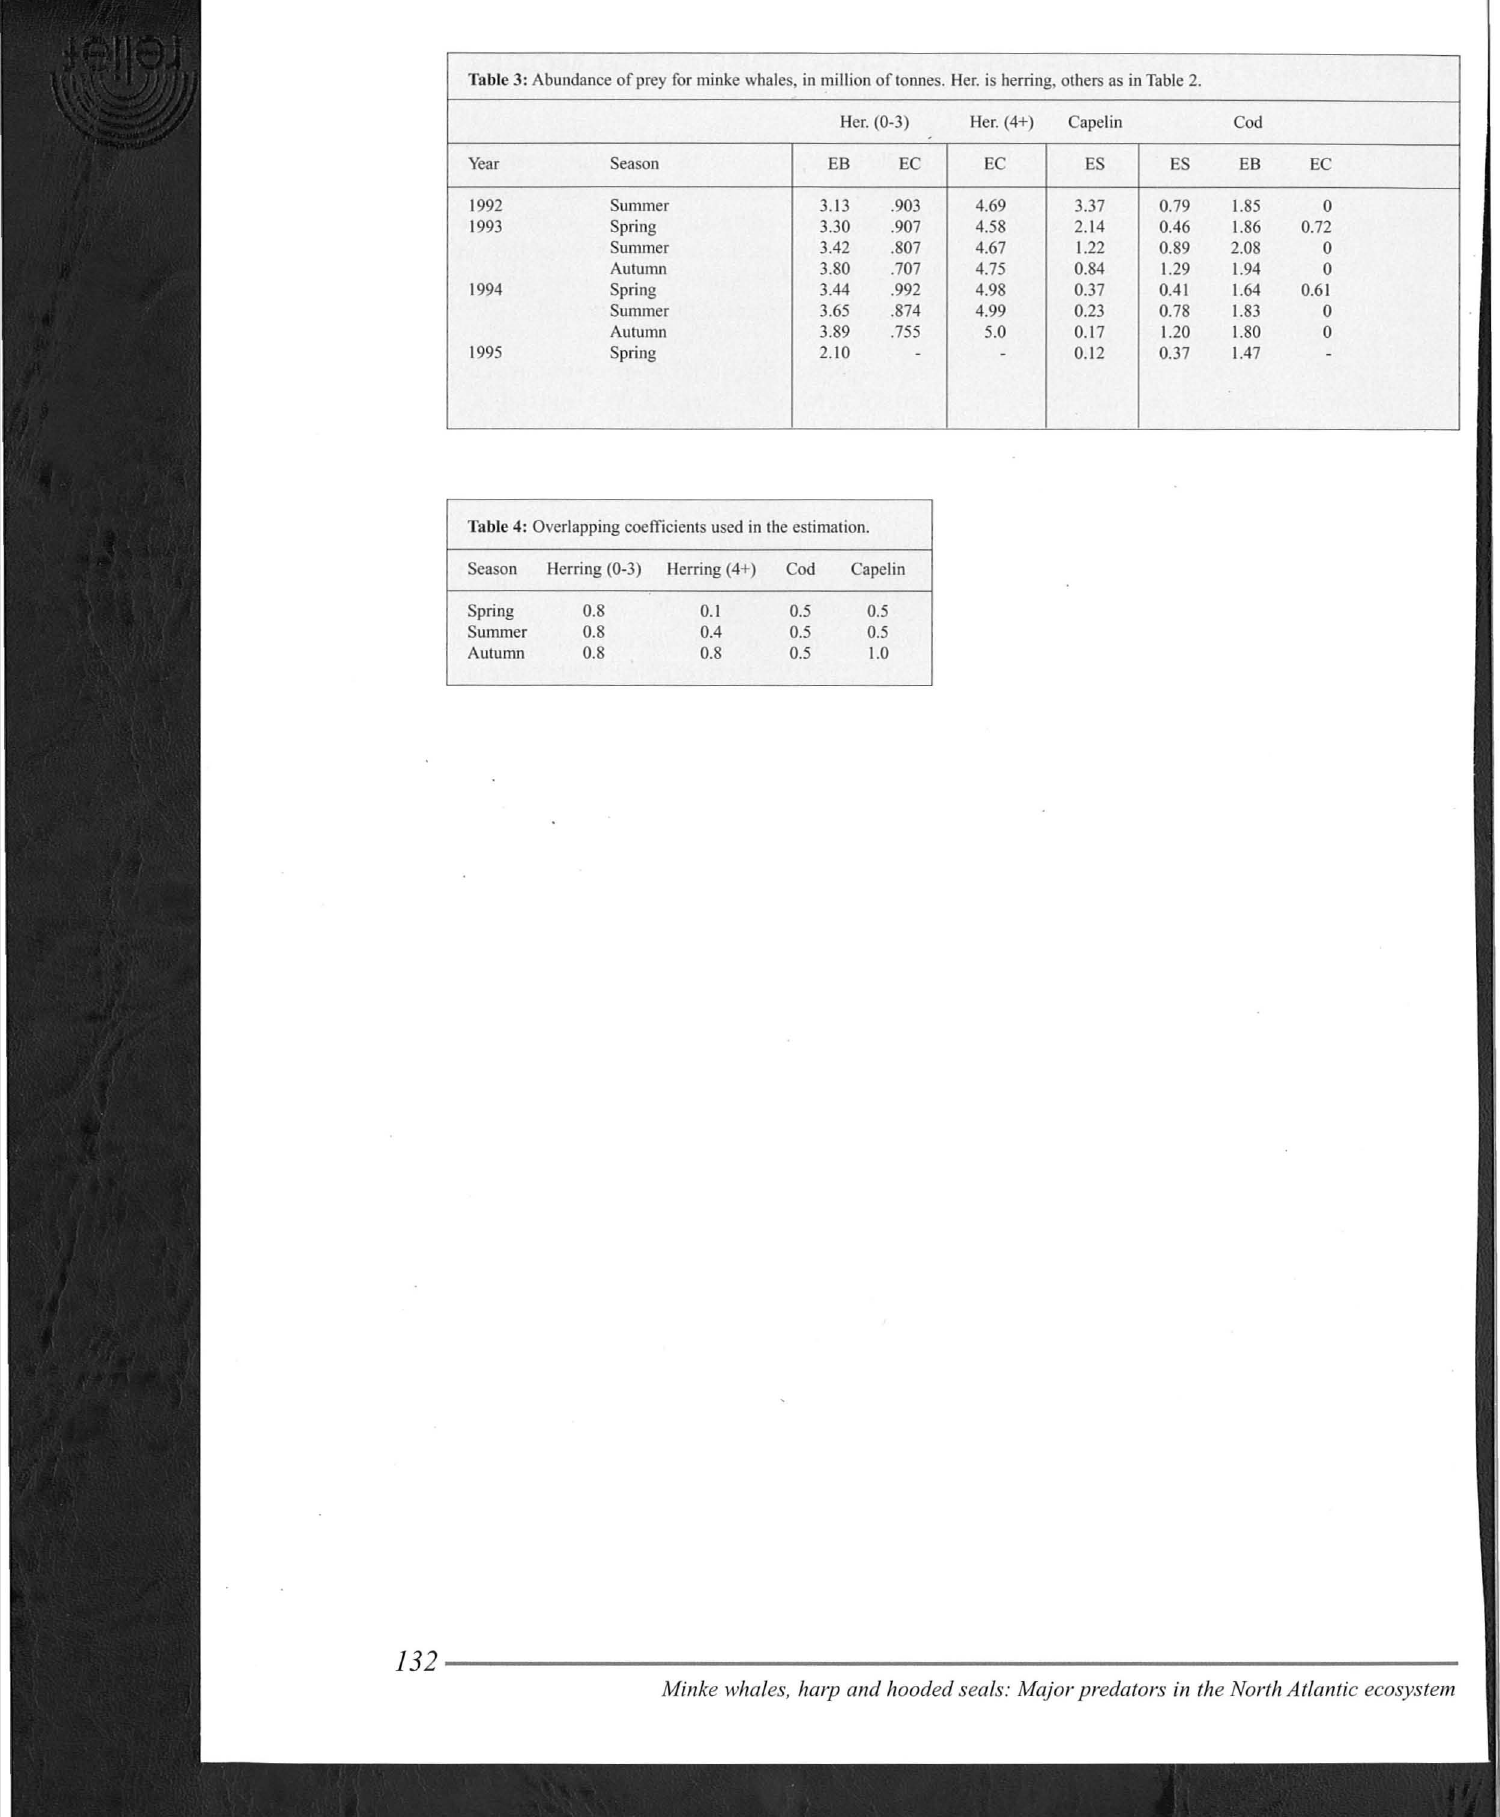
Table 3: Abundance of prey for minke whales, in million of tonnes. Her. is herring, others as in Table 2. Her. (0-3) Her. (4+) Capelin Cod Year Season EB EC EC ES ES EB EC